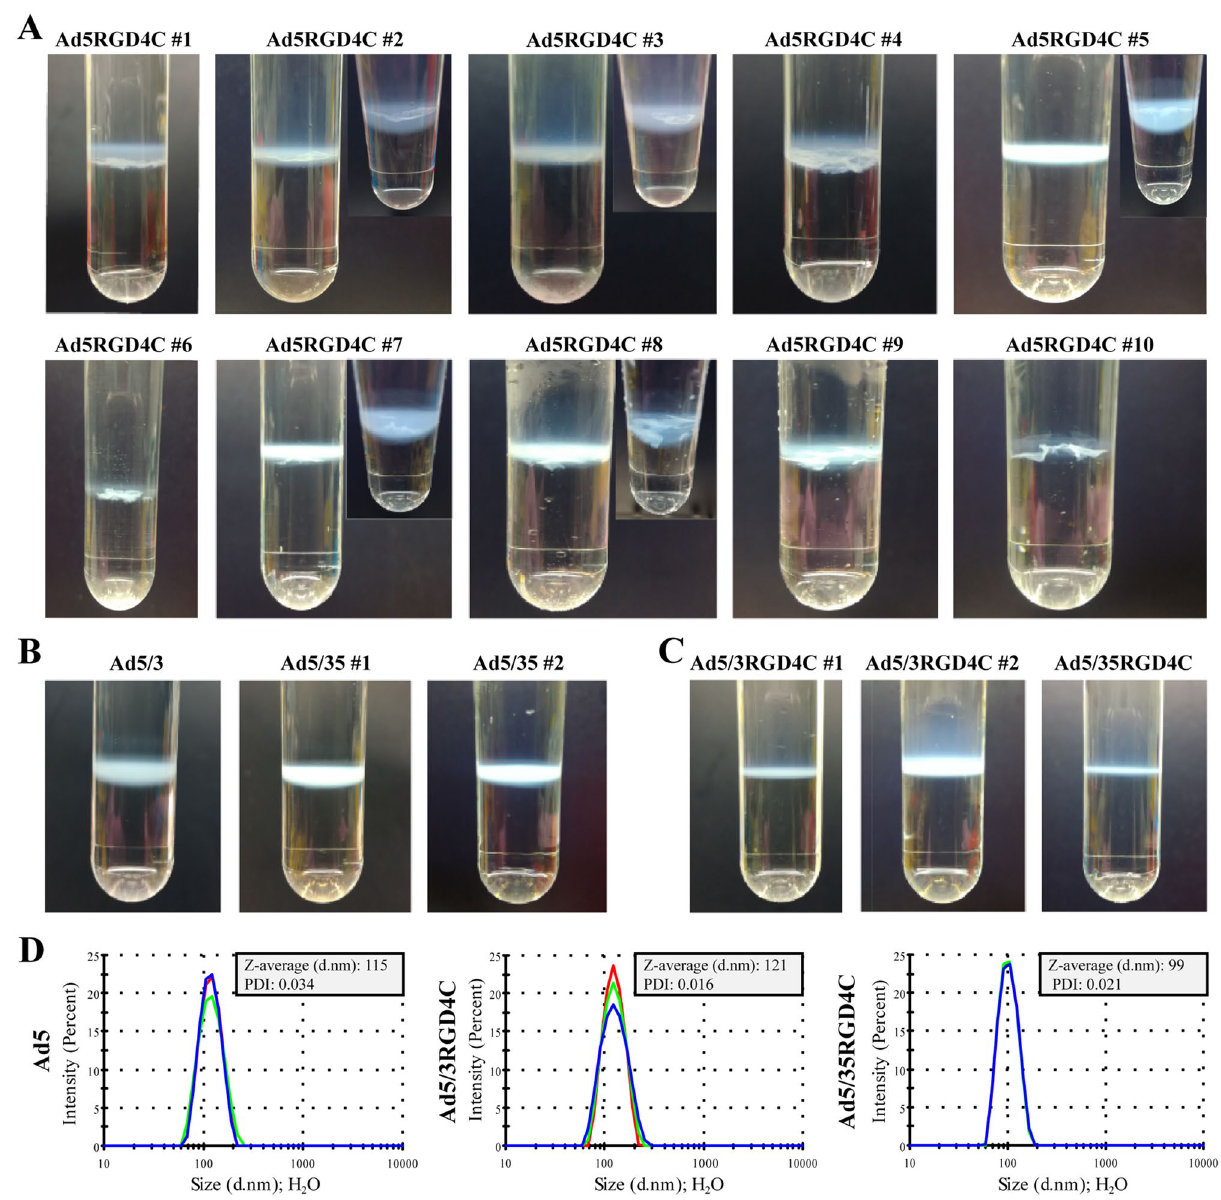
Figure 1. Recombinant adenoviruses with the RGD4C peptide inserted in the HI loop of the fiber knob domain form visible macroscopic and/or invisible microscopic aggregates during conventional two-cycle CsCl gradient purification. ( A ) Representative pictures of ten independent preparations of Ad5-delta-24- RGD4C-based rAds aggregated during 2 × CsCl gradient purification, especially in the second round of ultracentrifugation, forming floccules without a sharp band. ( B ) No macroscopic aggregation was observed for fiber-unmodified Ad5-delta-24 (two preparations) or fiber-chimeric Ad5/3-delta-24 (four preparations) and Ad5/35-delta-24 (six preparations). Representative pictures are shown. ( C ) No macroscopic aggregation was observed for complex fiber-chimeric Ad5/3-delta-24-RGD4C (two independent preparations) and Ad5/35- delta-24-RGD4C with the RGD-4C peptide fused to the C-terminus of the chimeric fiber via a glycine-serine 3 × (G4S) linker. ( D ) The absence of microscopic aggregation for all macroscopically non-aggregated rAds was confirmed using photon correlation spectroscopy, which measures size distributions by intensity, the intensity weighted mean hydrodynamic sizes (Z-averages, d.nm) and polydispersity indices (PDI) of nanoparticles in suspension. Representative measurements are shown. The measurements were carried out at a rAd concentration of 3 × 10 10 vp in 1 ml total volume in deionized water immediately after viral aliquot sample thawing. Each color curve represents an instrumental individual measurement